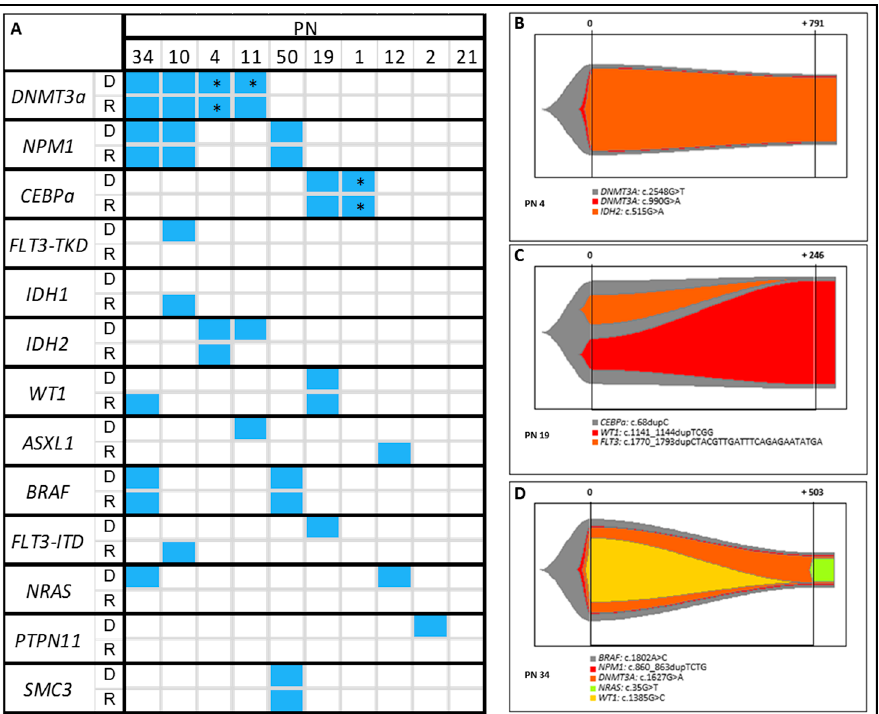
Figure 5. ( A ). Variants detected at diagnosis (D) and relapse (R) in ten relapsed AML patients. * Double variant. Examples of different patterns of clonal evolution in the cohort of relapsed AML. PN: patient number. ( B ). No change (PN 4), prevalence of clone identified at diagnosis. ( C ). Variant loss (PN 19) and ( D ). Both gain and loss of variants (PN 34), acquisition and loss of variants by the ancestral clone.